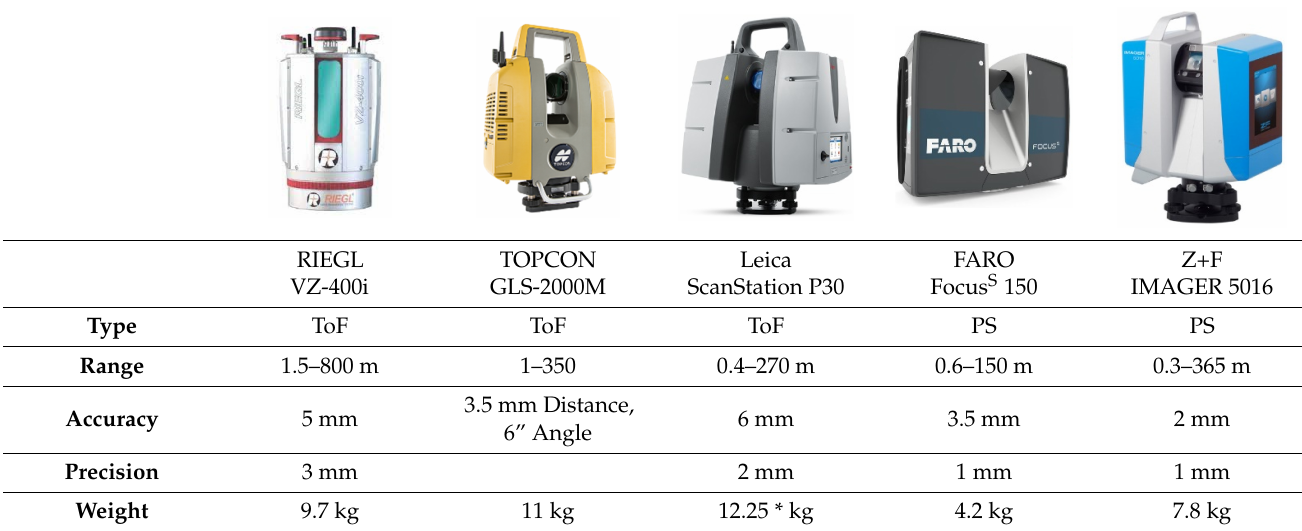
Figure 1. Point cloud of Castello del Valentino in Turin (Italy) obtained from a single scan. Table 1 presents a brief comparison between TLS devices. Table 1. Terrestrial laser scanning